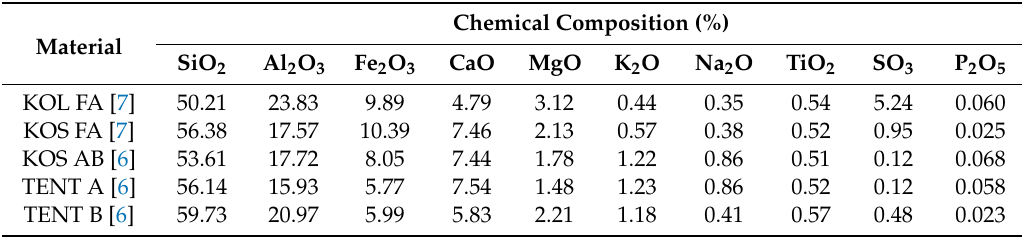
Table 3. Chemical composition of the used waste